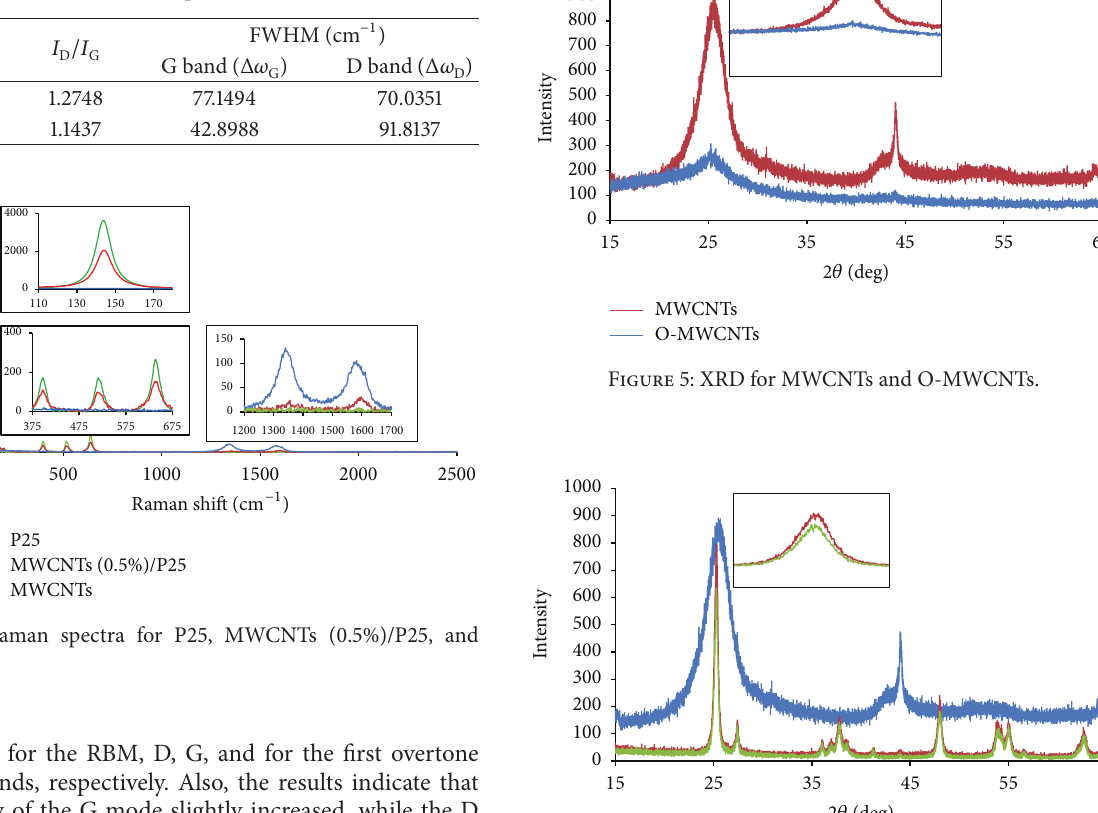
Table 1: A comparison of the Raman spectra features of the pristine and functionalized MWCNTs samples.